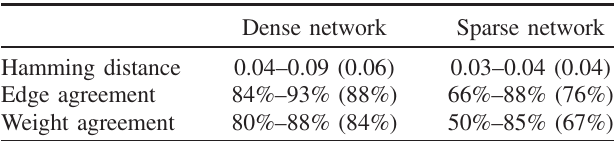
TABLE IV. Ranges (averages) of pairwise intercoder reliability metrics for two lab sessions.